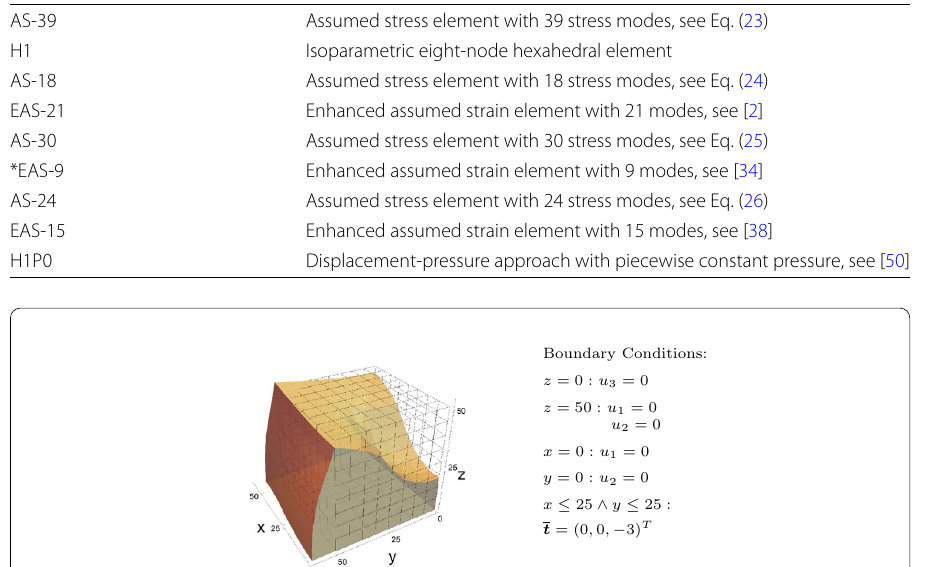
Table 3 Overview of considered elements